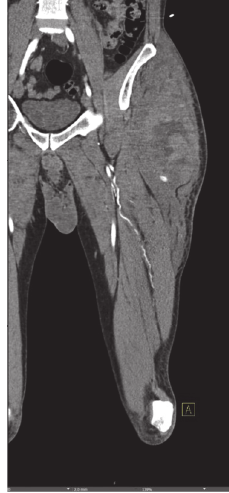
Figure 2: Coronal CT reconstruction further details the area of extravasation and associated hematoma.